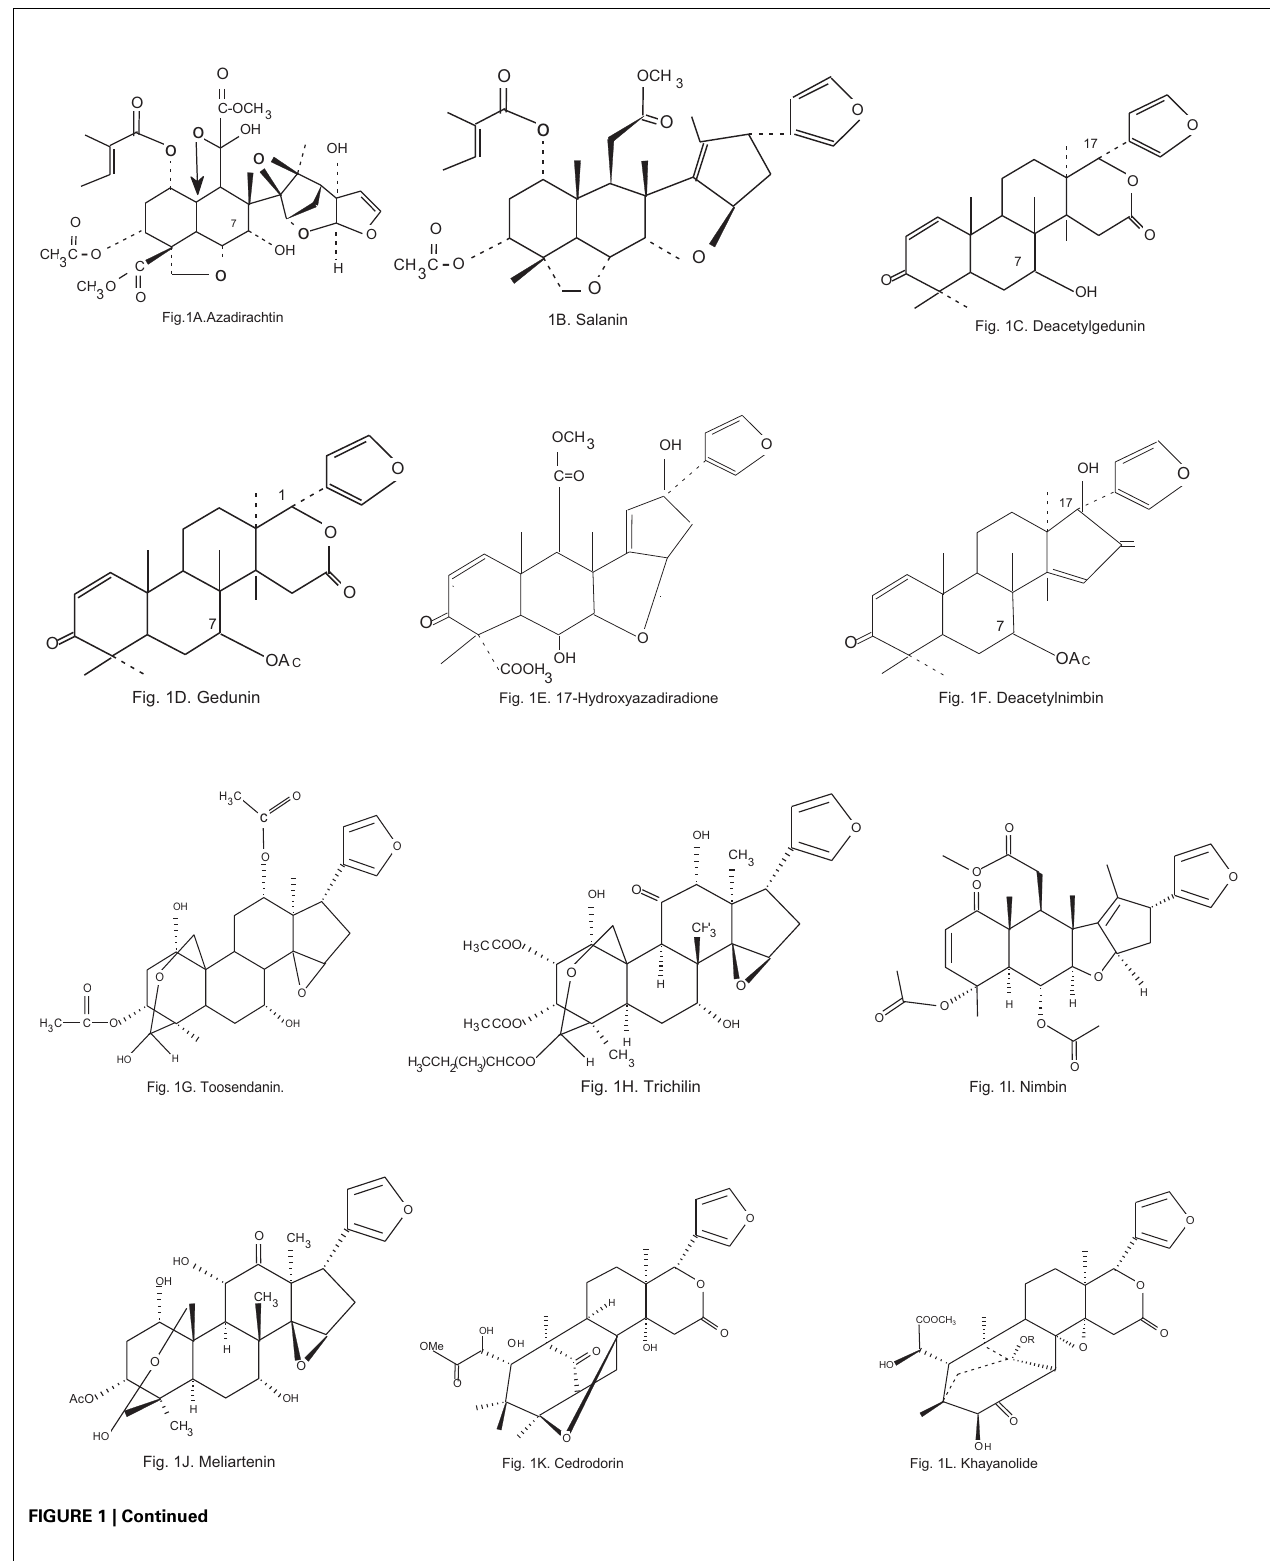
Fig. 1J. Meliartenin Fig. 1K.